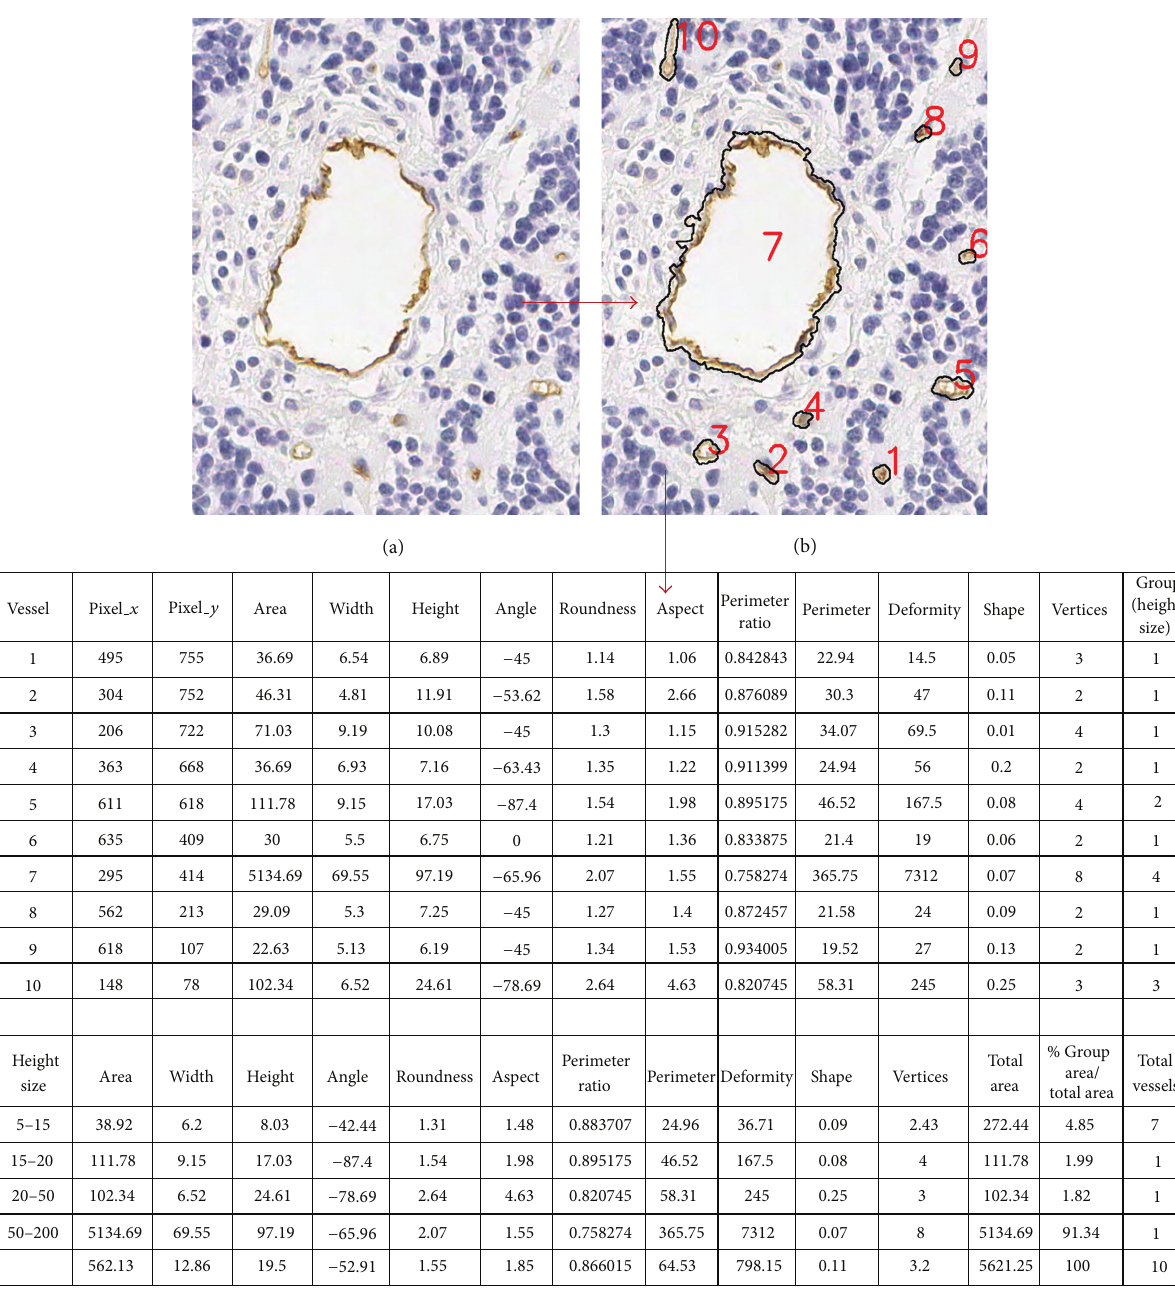
Figure 8: Results provided by AngioPath. (a) Original image. TMA sample with 10 vessels, (b) segmented vessels and labeled and (c) morphometric measurements for each vessel and for each group of vessels according to their height.